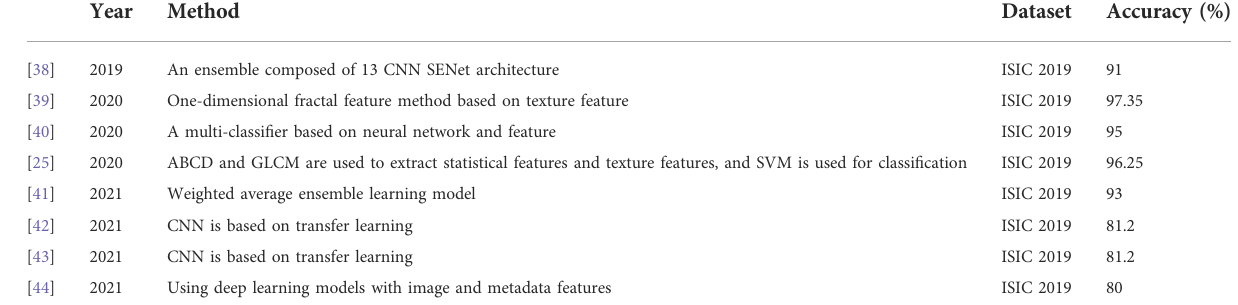
FIGURE 8 Performance comparison.